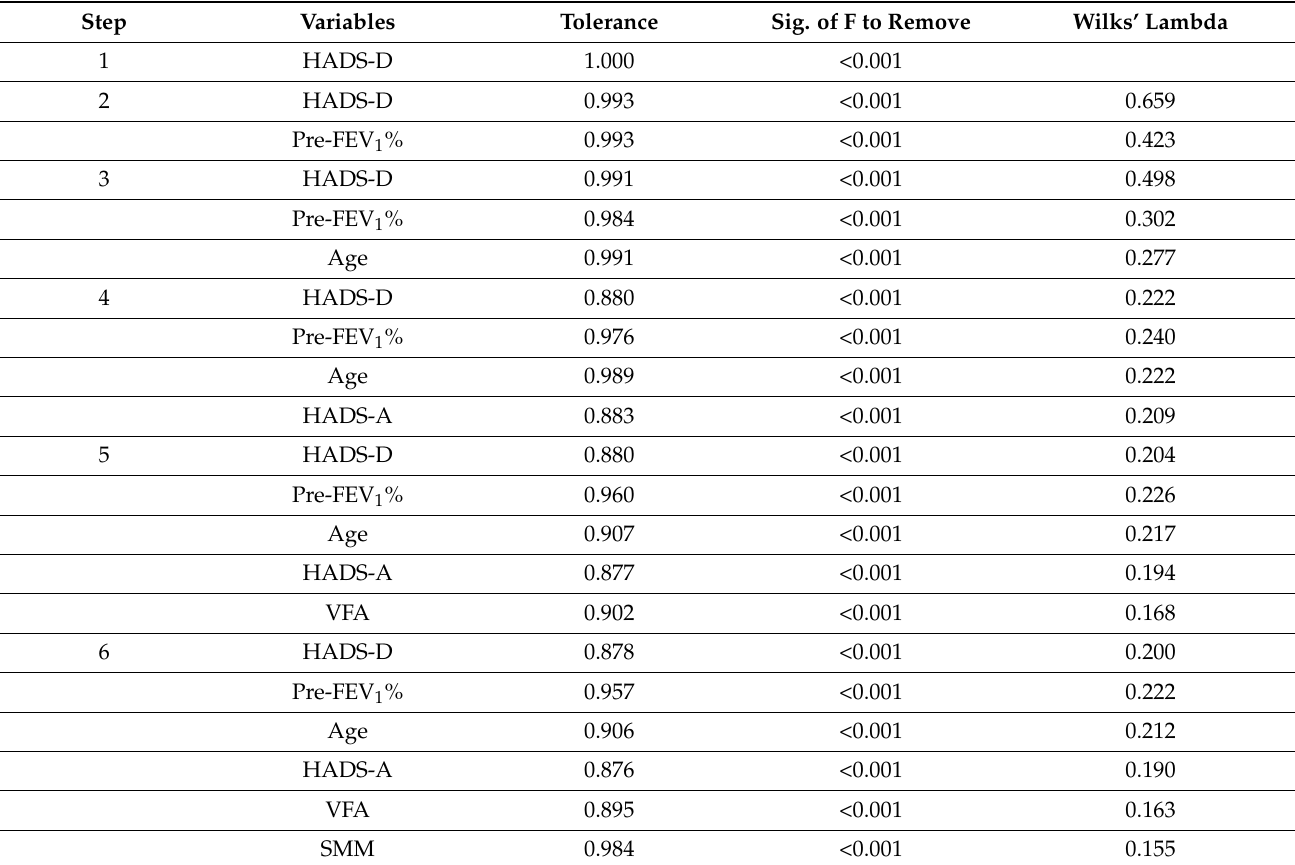
Table 4. Canonical discriminant function analysis in the training set.